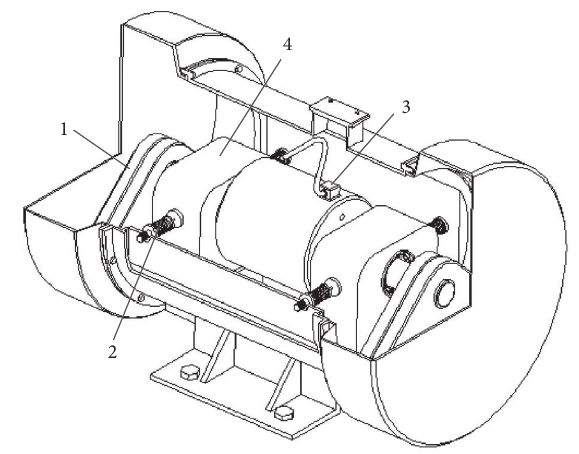
Figure 5: Structure of the 4-DOF chaotic vibrating screen. 1: support; 2: outer screen frame; 3: inner screen box; 4: rotary support device; 5: kinematic constraint mechanism; 6: chaotic exciter; 7: bearing spring.